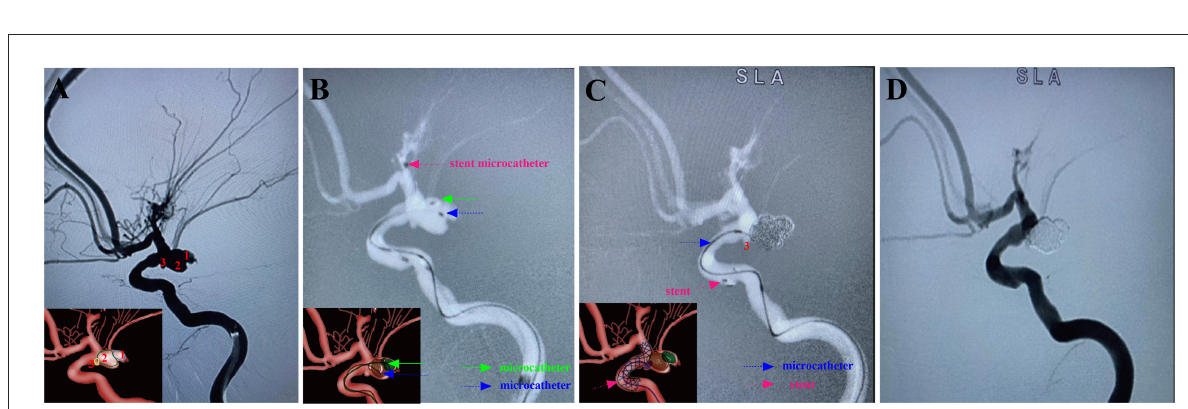
FIGURE4 A ruptured right PcomA aneurysm (Hunt-Hess grade IV) in a 66-year-old female was treated using the stent-assisted MCP technique. In addition, the patient had coexisting Moyamoya disease. Arabic numerals indicate the ascus of an IA. (A) DSA (working angle) showed a cauliflower-shaped irregular aneurysm of PcomA with three daughter sacs. (B) The stent-microcatheter (pink arrow) was placed at the beginning of the M1 segment of the MCA. Double-coil microcatheters (blue and green arrows) were introduced in different sacs of the IA at appropriate surgical angles. (C) We used the Jailing technique to coil the aneurysm with the assistance of an Enterprise 2 stent (Codman Neurovascular, Raynham, Massachusetts, USA). Embolization was first performed with a microcatheter (green arrow) navigating into the upper daughter sac and coils packing (image of digital non-subtraction angiography). The coils were passed through the other microcatheter (blue arrow) to embolize the middle sacs, and then the microcatheter was withdrawn into the lower sac for coil embolization. (D) Post-embolization digital subtraction angiograms at the working angle exhibited complete occlusion at Raymond grade I. The inserts in the lower right corner illustrated an aschematic diagram of the MCP process of the IA (A–C)